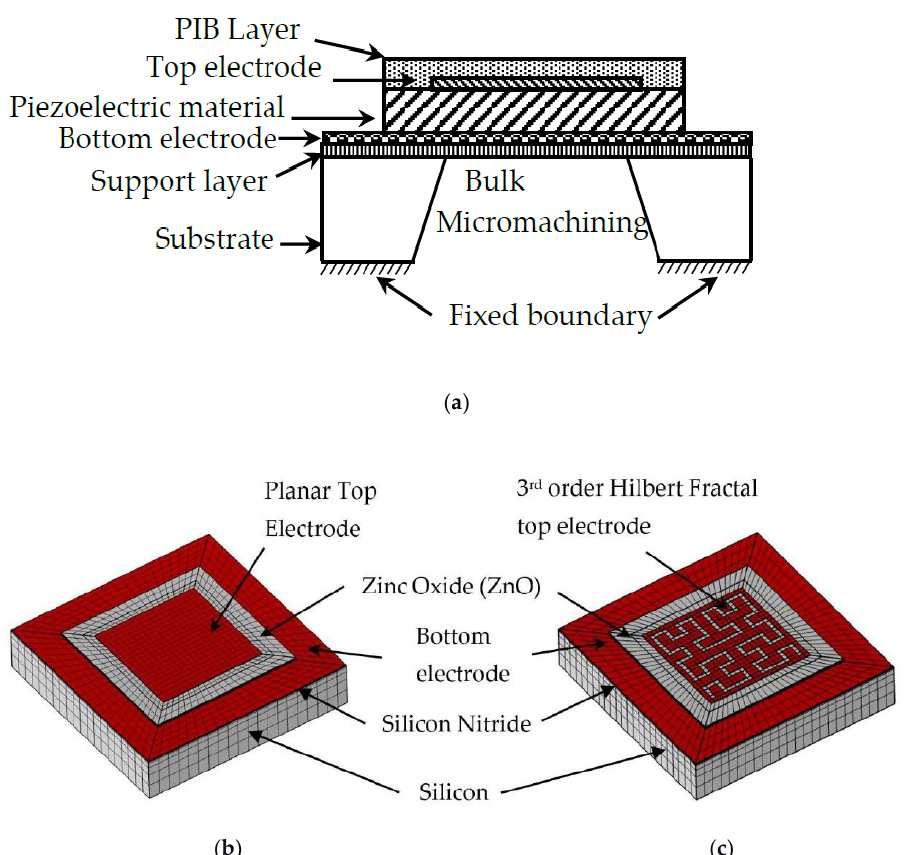
Figure 1. ( a ) Schematic of FBAR structure with Polyisobutylene (PIB) layer. Meshed COMSOL model of FBAR with ( b ) planar electrode, and ( c ) 3rd-order Hilbert fractal electrode.